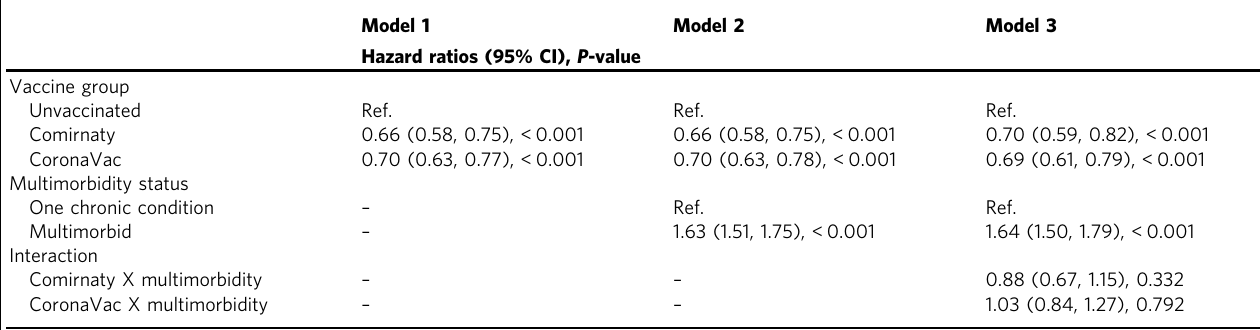
Table 2 Hazard ratios with 95% con fi dence intervals (CI) of adverse events of special interest generated from Cox proportional hazard models with entropy